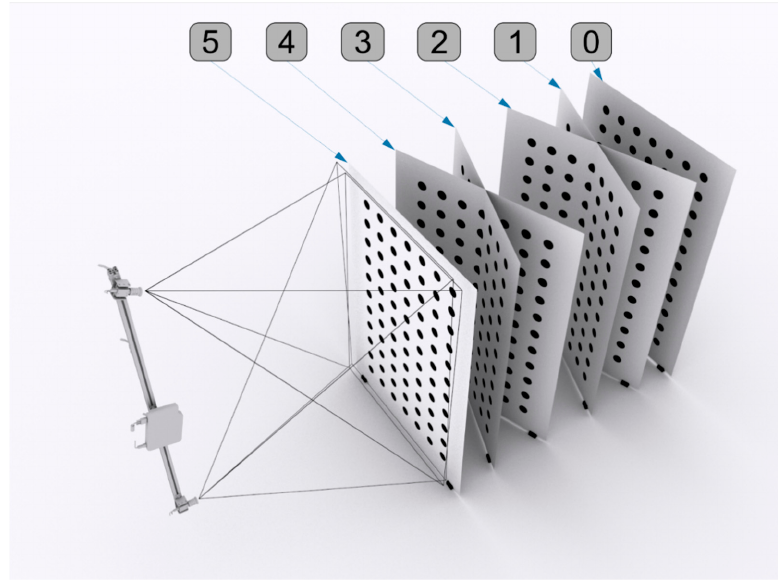
Figure 10. Single DMH calibration process: calibration artefact positions 0–5 used during camera